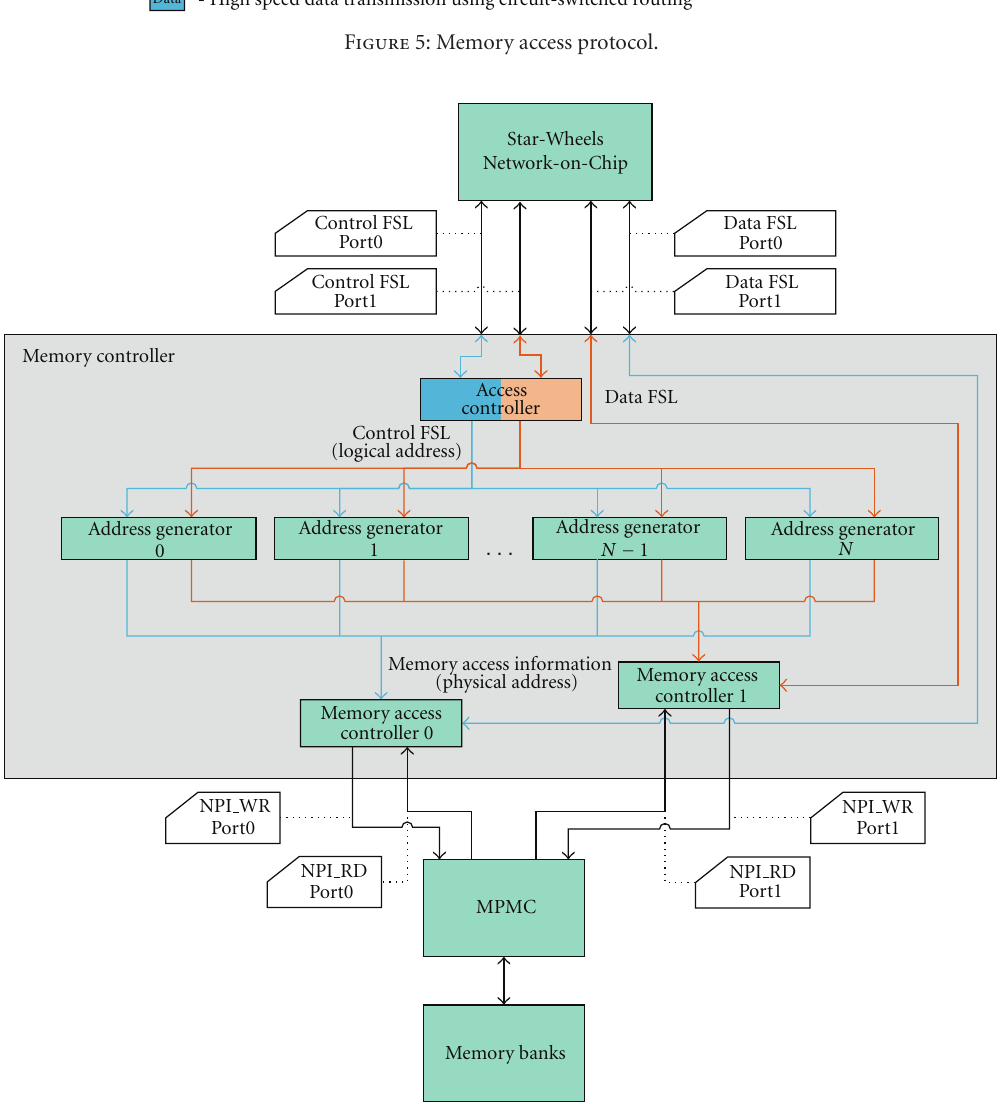
Figure 6: Overview of the adaptive memory core with four NPIs and two Star-Wheels NI